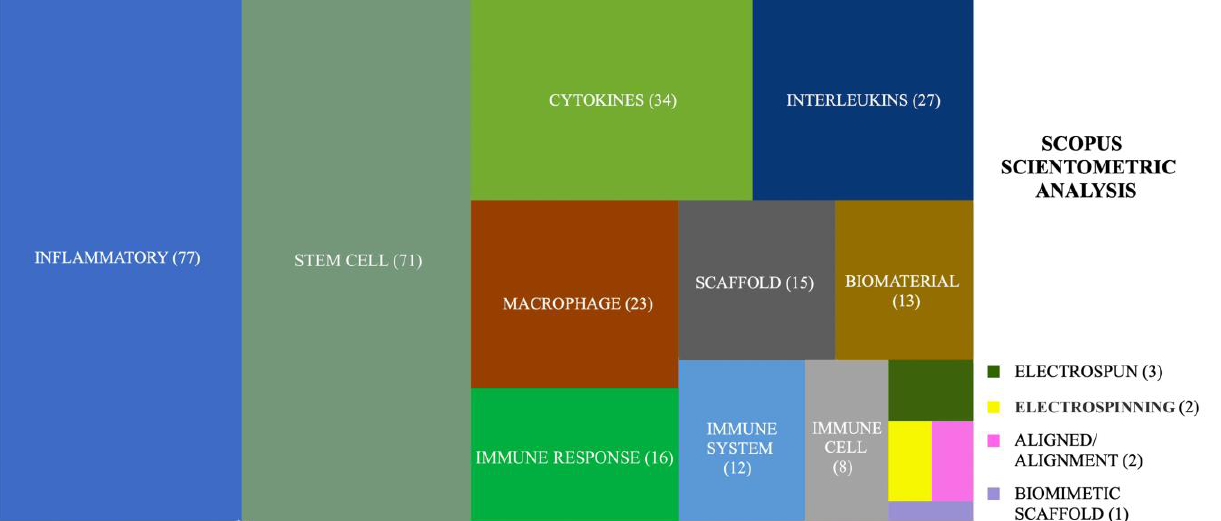
Figure 2. The scientometric analysis conducted on Scopus database (304 total articles) with the aim to assess the different research topics concerning the immunoregeneration of tendon discussed in this review. The legend indicates the different keywords used in the research whereas the number of total publications for each keyword is written inside the box.